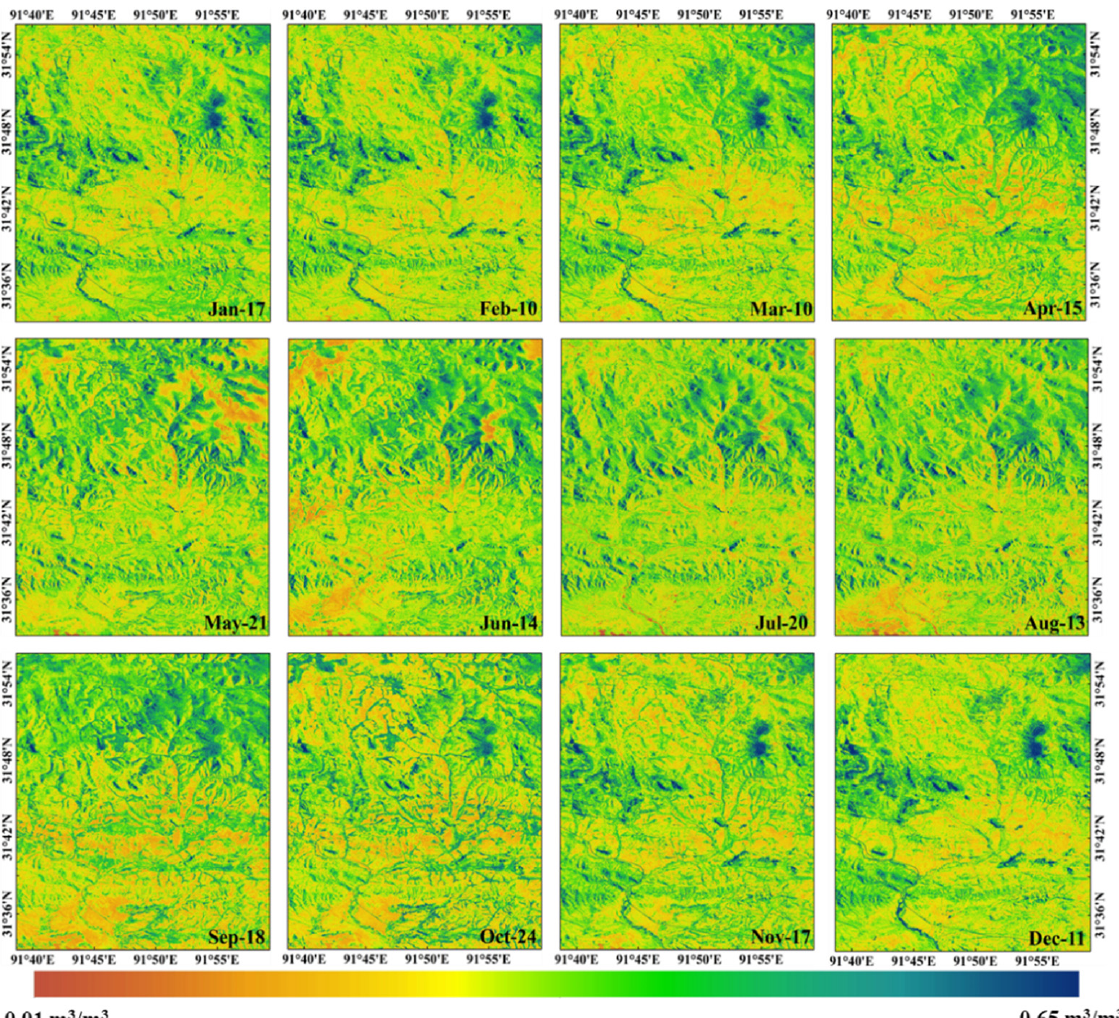
Figure 5. Soil moisture for ascending orbit of Naqu network for 2020.